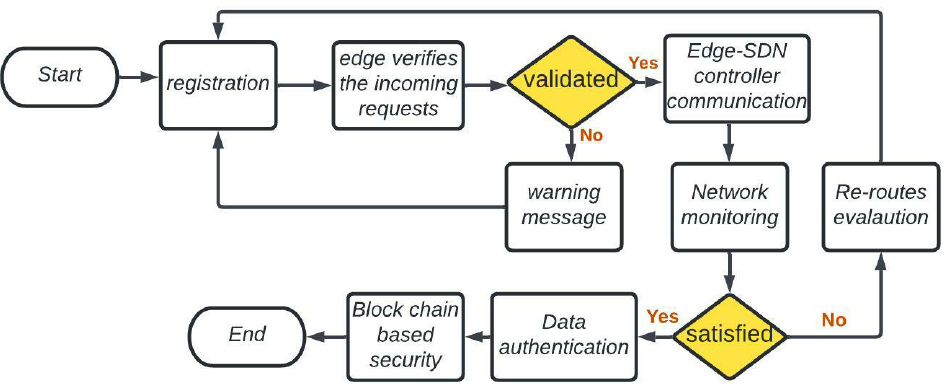
Figure 3. Flowchart of the proposed system for SDN-based security with blockchain.